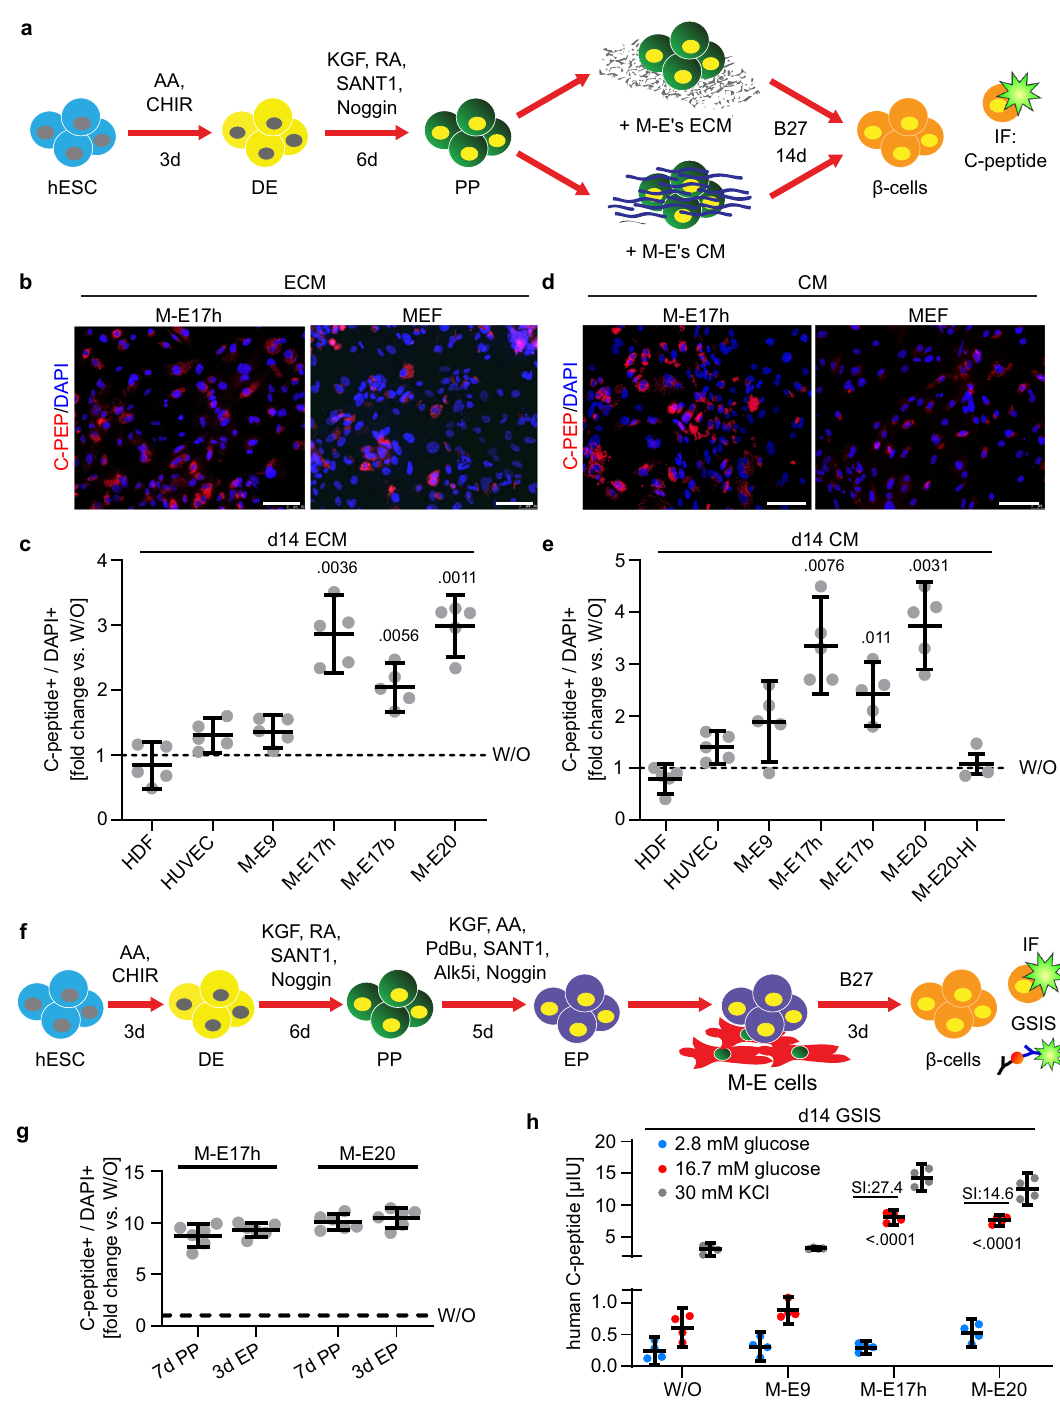
had a treatment with SERPINF1 (2.2-fold over control at 1 μ g/ml concentration), WNT5A (2.5-fold, 500 ng/ml) and Endocan (2.5- fold, 50 ng/ml). We also monitored Islet-1 (ISL1) expression using a ISL1 Cre/ + ; pCAG loxP-STOP-loxP-EGFP hESC line engineered for lineage tracing of ISL1 + cells 67 . Factors that signi fi cantly enriched CHGA + cells show similar induction of ISL + endocrine cells as assessed by GFP fl uorescence (Supplementary Fig. 6A, B). To test β -cell speci fi cation by single factors, we analyzed INS and C-peptide protein presence after a 3-day EPs treatment (Fig. 4e, f and Supplementary Fig. 6C, respectively). EPs treatment with PDPN, SERPINF1, WNT5A and